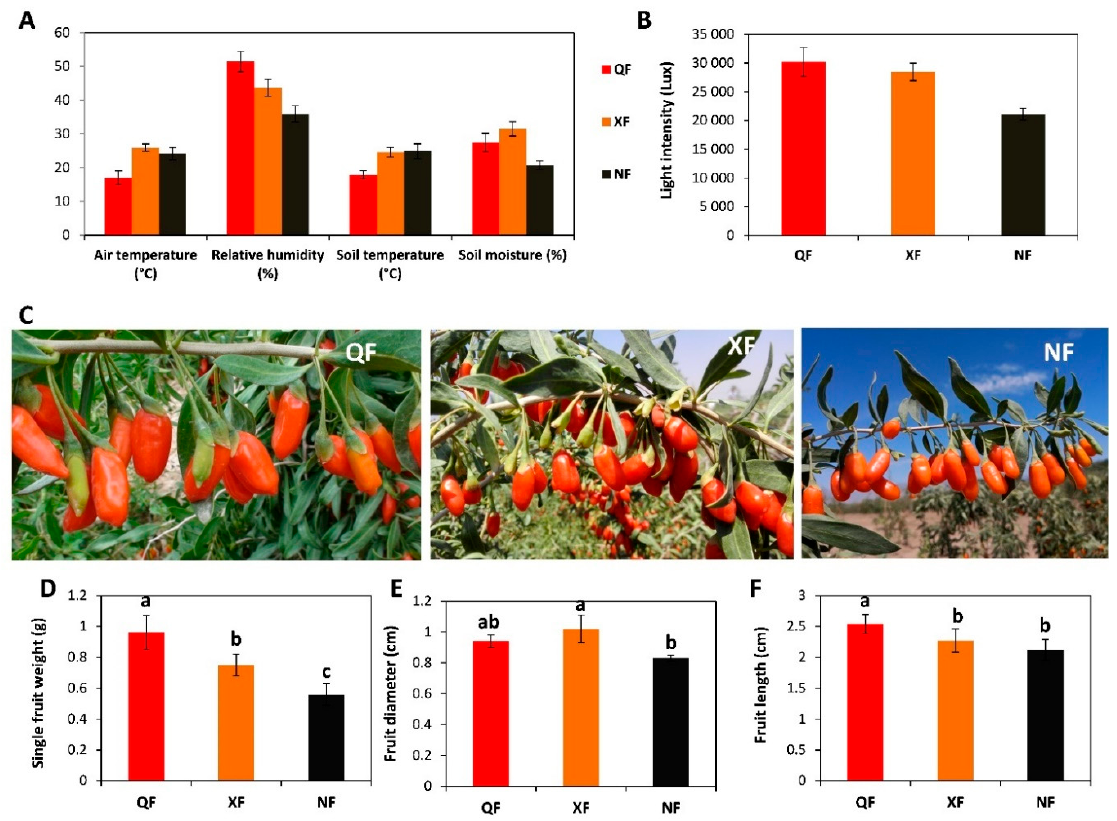
Figure 1. Meteorological conditions of three typical growing areas of wolfberry in China and measurement of the size of fruits obtained from each location. ( A ) Average air temperature, relative humidity, soil temperature and soil moisture content in the three locations during the fruit growth period; ( B ) light intensity in the three locations during the fruit growth period; ( C ) pictures of the wolfberry fruits at each location during ripening period; ( D ) single fruit weight, ( E ) fruit diameter and ( F ) fruit length. QF, NF and XF represent Qinghai, Ningxia and Xinjiang growing area, respectively. Bars represent the average values with SD from various measurements. The letter above bars represent the results of statistical tests and bars with different letters are significantly different at p <0.05.